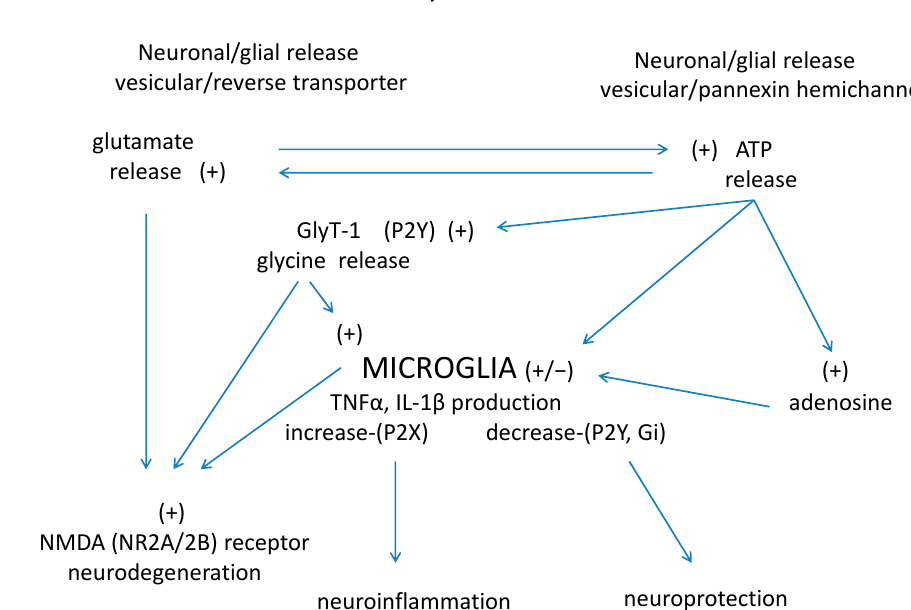
Figure 3. Purinergic–glycinergic cross-talk and microglia activation in neurodegenerative–neuroinflammatory disorders in the retina: A hypothetical model. Impaired microcirculation evokes energy deficiency in the retina leading to increased release of glutamate from neurons or macroglial cells by vesicular exocytosis or reverse-mode operation of excitatory amino acid transporter (EAAT). Cellular energy deficiency also evokes increase in ATP efflux from neurons or glia cells by Ca 2+ -dependent exocytosis or opening of pannexin hemichannels. There may be a self-strengthening interaction between glutamate and ATP: Glutamate induces ATP release and ATP efflux leads to an increase of glutamate release. In addition, glycine is released from energy-compromised neurons and macroglia by reverse-mode operation of glycine transporter 1 (GlyT-1) in the retina. Excess release of glycine and glutamate overactivates extrasynaptic NR1/NR2B type NMDA receptors, which evokes neurotoxicity. In contrast, synaptic NR1/NR2A type NMDA receptors mediate neuroprotection. Increased glycine release induces further release of glycine from activated microglial cells by altering Ca 2+ transients and shifts neutral amino acid transporter (NAAT) operation in reverse-mode. Glycine-induced glycine release from microglia, a self-strengthening interaction, facilitates glutamate-induced overstimulation of NMDA receptors, triggering excytotoxicity. This mechanism can be an additional self-strengthening interaction: Glycine induces further release of glycine from activated microglial cells, which participates in extrasynaptic NMDA receptor overstimulation. The evoked NMDA receptor-mediated neurotoxicity primarily damages ON ganglion cells in the retina. Further in the interactions: ATP released by cellular energy deficiency stimulates GlyT-1 normal operation via activation of P2Y purinoceptors, which decreases extracellular glycine levels. GlyT-1 inhibitors inhibit pathological reverse-mode operation of GlyT-1. These two effects on GlyT-1 operation inhibit microglia activity by decreasing extracellular glycine concentrations. ATP released from stressed neurons and glia cells stimulates P2X and P2Y purinoceptors expressed in microglia, which induces stimulation or inhibition of the production and release of TNF α and proinflammatory cytokines (IL-1 α , IL-1 β , IL-6, IL-12). Adenosine produced by a breakdown of ATP or released from cells stimulates or inhibits microglia activity via adenosine receptors; the participating receptors with opposite effects are the inhibitory A 1 and A 3 and the stimulatory A 2A and A 2B adenosine receptors. The balance of this tripartite interaction may either be shifted to a neurodegenerative–neuroinflammatory direction or lead to neuroprotection serving inflammation resolution and neuronal